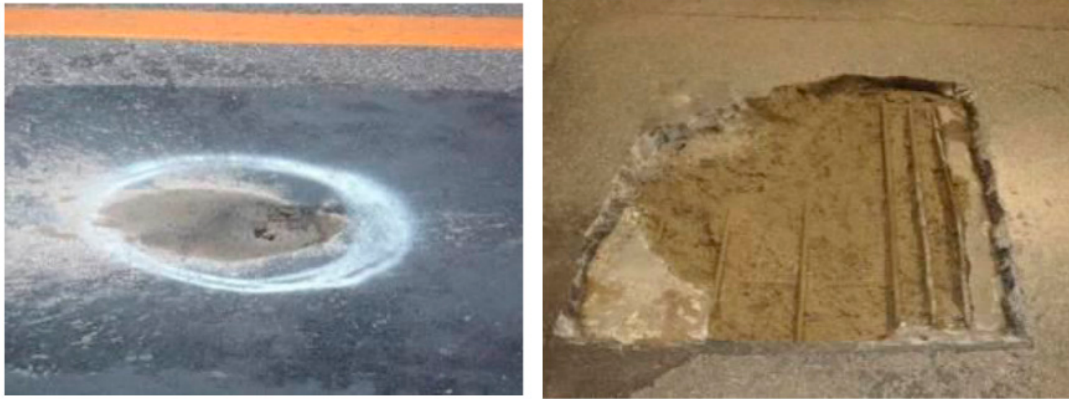
Figure 2. Deterioration example in East Japan.